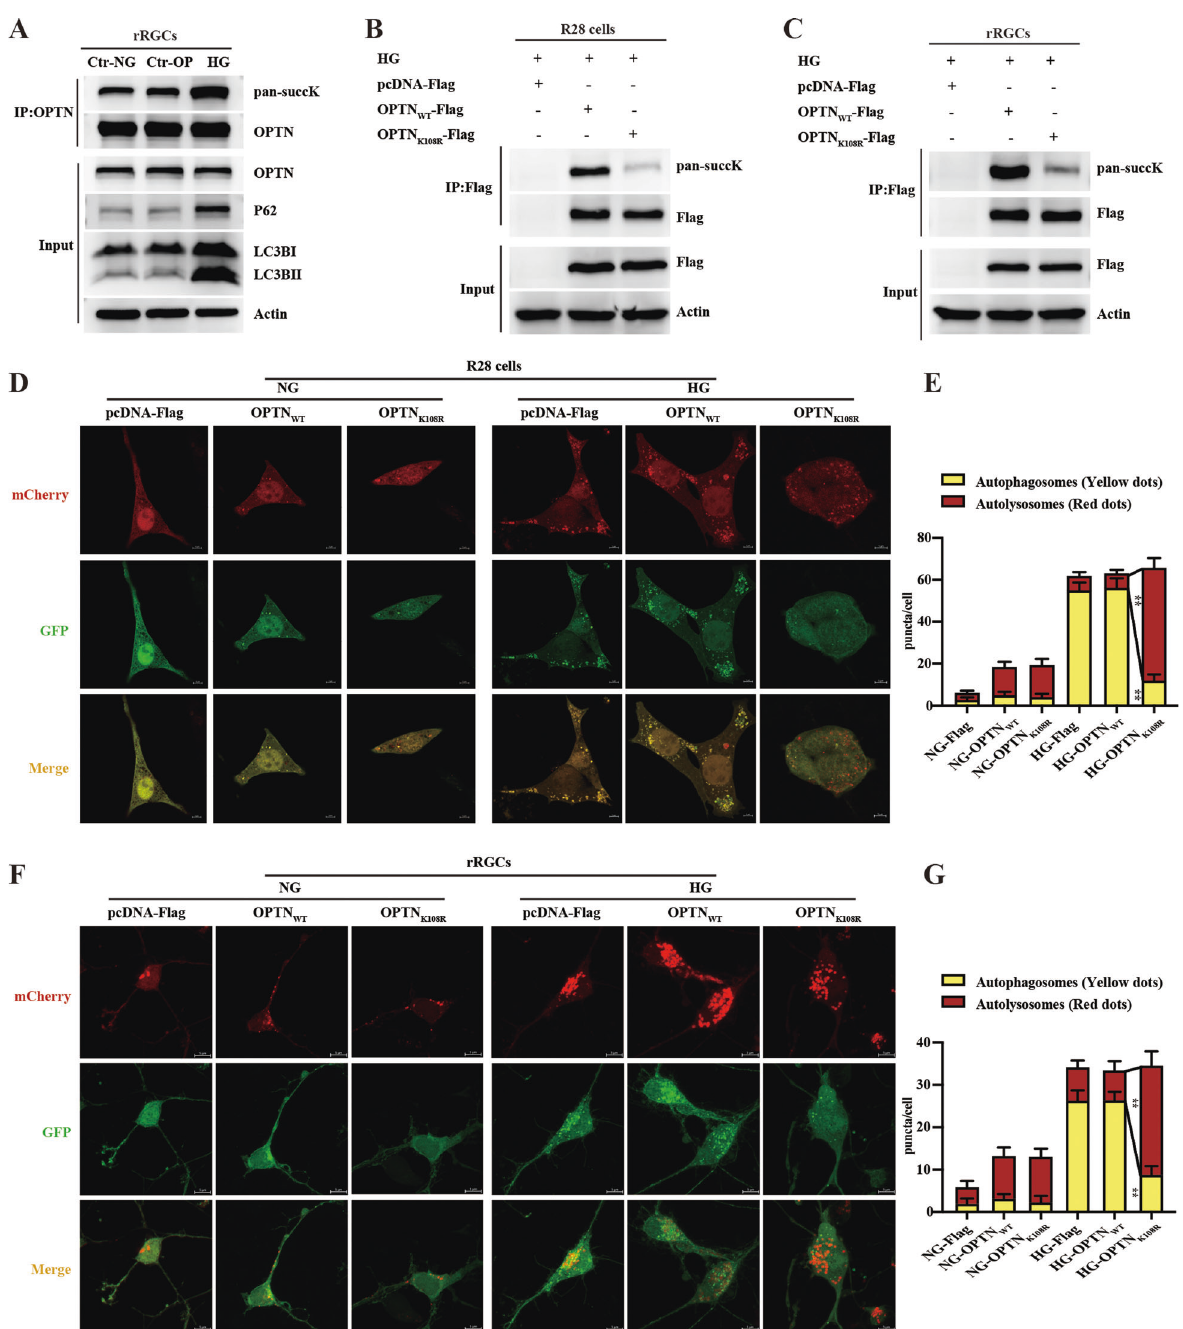
Fig. 4 Desuccinylation of OPTN activates autophagic fl ux in R28 cells and rRGCs. A High glucose induced the upregulation of OPTN succinylation and the blockade of autophagic fl ux in primary rRGCs. The rRGCs were cultured under high-glucose conditions (25 mM D-glucose), 5.5 mM D-glucose as a control group, and 20 mM mannitol (plus 5.5 mM glucose) as a control for osmotic pressure (OP). The Flag tag was immunoprecipitated, followed by immunoblotting with an anti-pan-succK antibody. Whole-cell lysates were used as the input and analyzed by western blotting for the expression of OPTN and the autophagic markers LC3BII/I and P62. B , C The OPTN K108R mutant abolished the succinylation of OPTN in R28 cells and primary rRGCs. Cells were transfected with the indicated plasmids under high-glucose conditions (25 mM D-glucose), and the Flag tag was immunoprecipitated, followed by immunoblotting with an anti-pan-succK antibody. Whole-cell lysates were used as the input and analyzed by western blotting for the expression of Flag and Actin. D , F The OPTN K108R mutant activated autophagic fl ux in R28 cells and primary rRGCs. Representative images of primary rRGCs and R28 cells transfected with mCherry- GFP-LC3B lentivirus following transfection with the indicated plasmids under normal or high-glucose conditions (5.5 mM or 25 mM D-glucose). Scale bar = 5 μ m. E , G The number of red (autolysosomes) and yellow puncta (autophagosomes) per cell was determined using ImageJ. Twenty cells from six independent experiments were analyzed in each group. The data are shown as the mean ± SD ( n = 6). * p < 0.05, ** p < 0.01. HG high